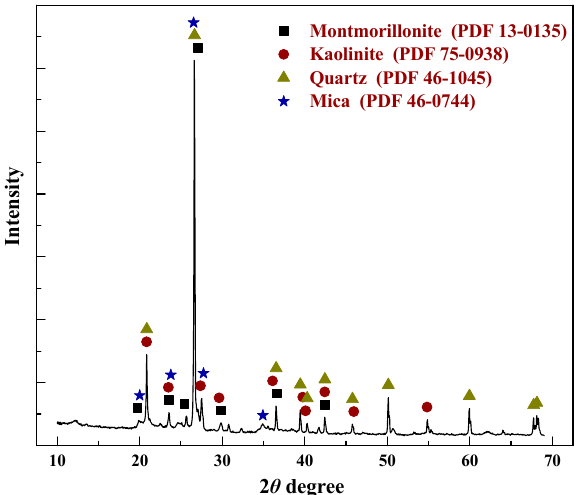
Figure 2. XRD pattern of the experimental rare earth ore.